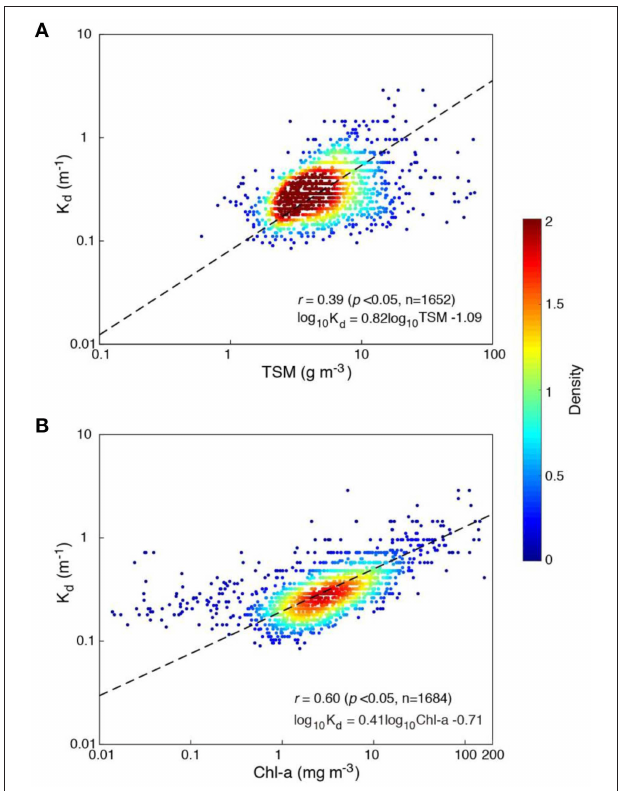
FIGURE 4 | Density scatter plots showing the relationship between in situ K d (m − 1 ) and: (A) in situ TSM (g m − 3 ) and (B) in situ Chl-a (mg m − 3 ). The black dotted line is the best-fit linear regression line for all the data in each comparison. The color bar marks density.